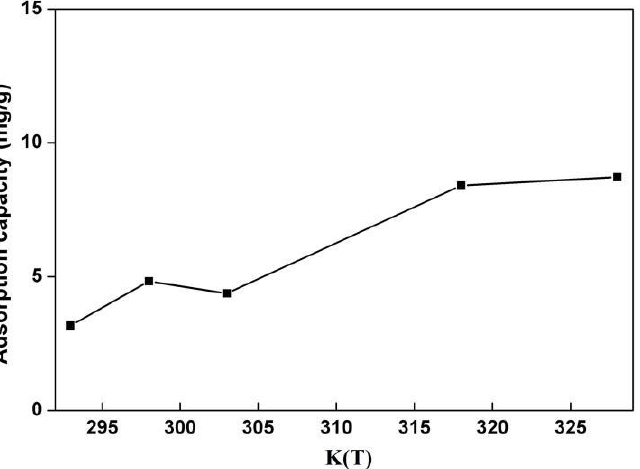
Figure 7. Effect of temperature on adsorption of Sr on soil colloids. Soil-liquid rate = 0.8 g · L − 1 , pH = 6 ± 0.1, C[Sr 2+ ] inital = 100 mg · L − 1 .